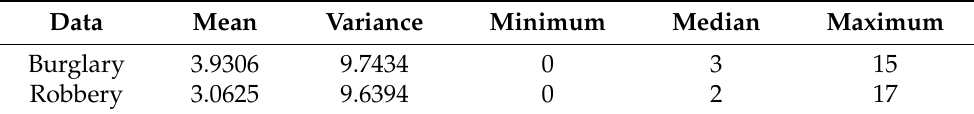
Table 8. Summary statistics for the monthly number of burglaries and robberies in beat 26. Data